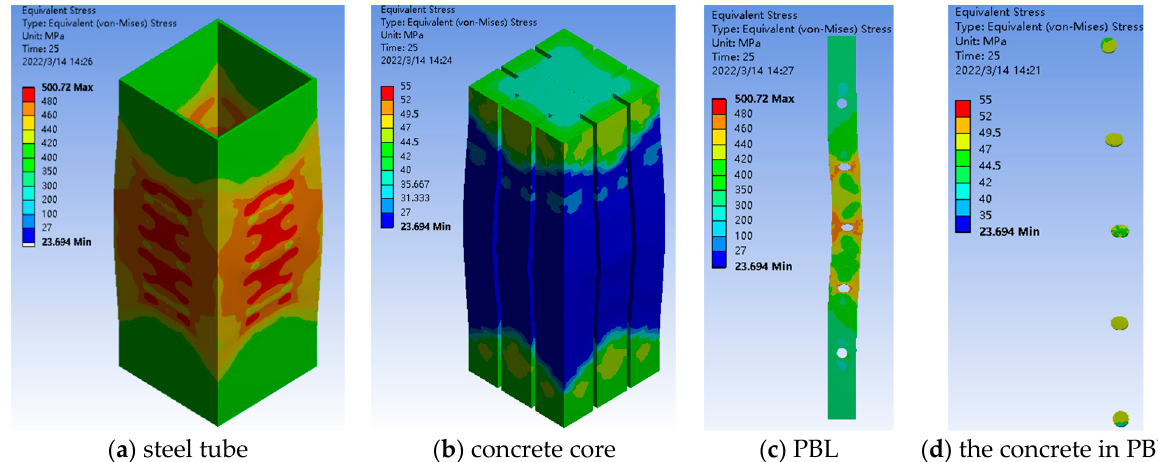
Figure 9. Failure mode and the equivalent stress of Type B.